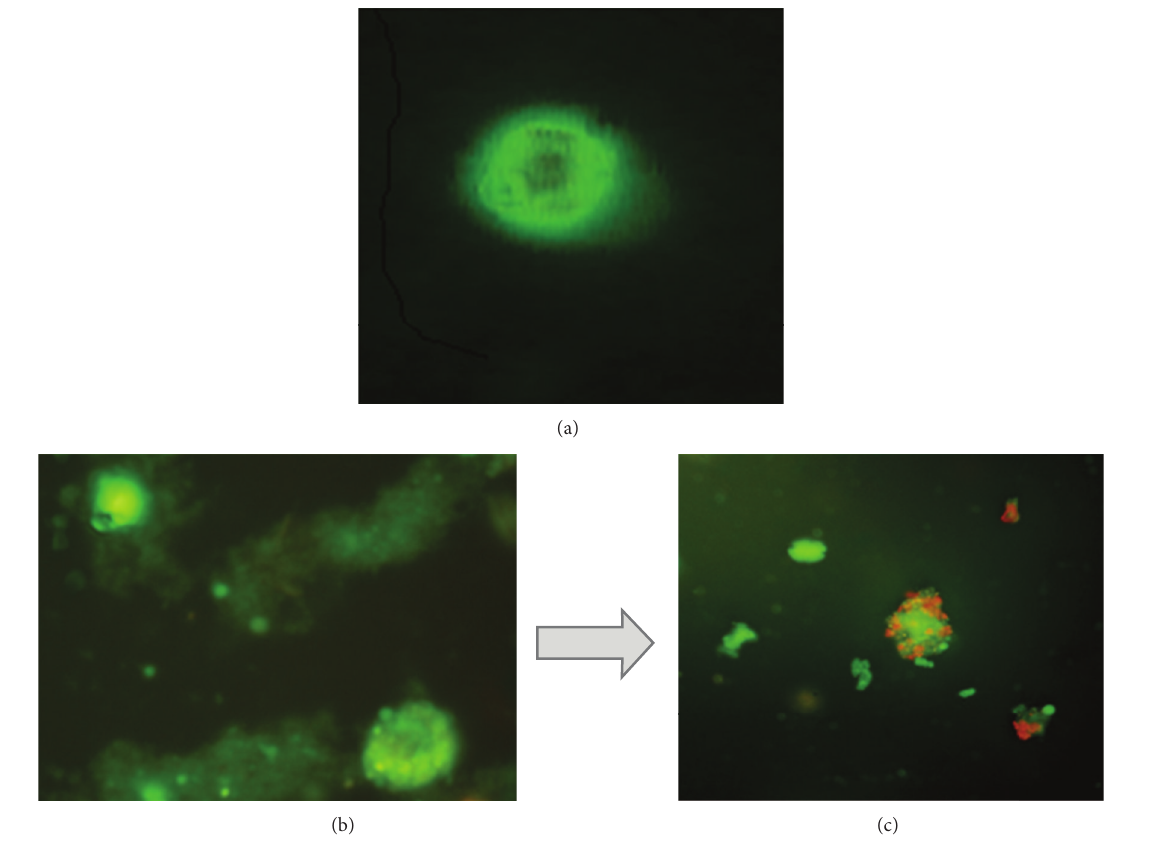
Figure 2: Bacterial killing by colostral phagocytes. Phagocytes with PEG microspheres with adsorbed glycine internalized (panel (a)). The phagocytes were incubated with bacteria on a shaker 50 rpm for 30min at 37 ∘ C. After washing at 4 ∘ C, cells were stained with acridine orange and analyzed by fluorescent microscopy. Orange-stained bacteria (dead) and green-stained bacteria (alive). Phagocytosis of bacteria (panel (b)) and bacterial killing (panel